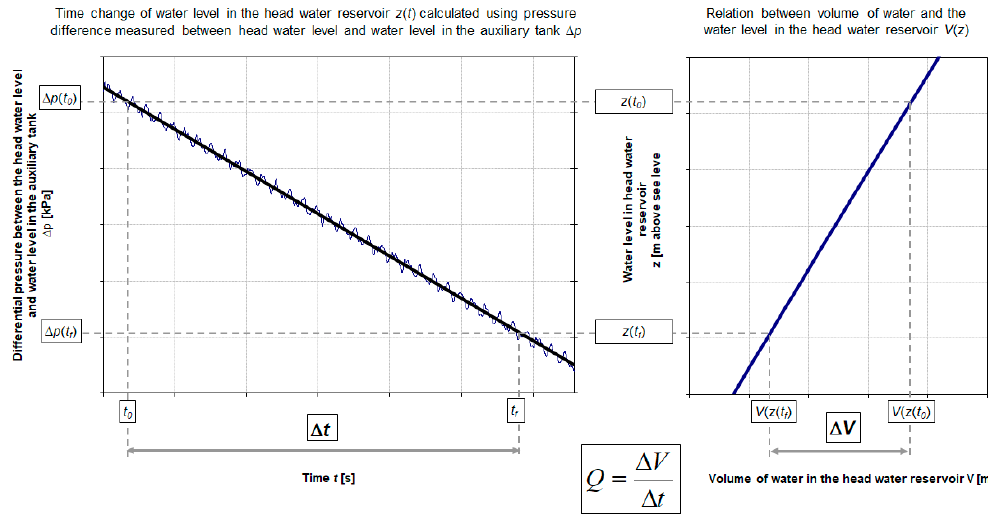
Figure 3. The volumetric gauging method—basic rules of flow rate determination.